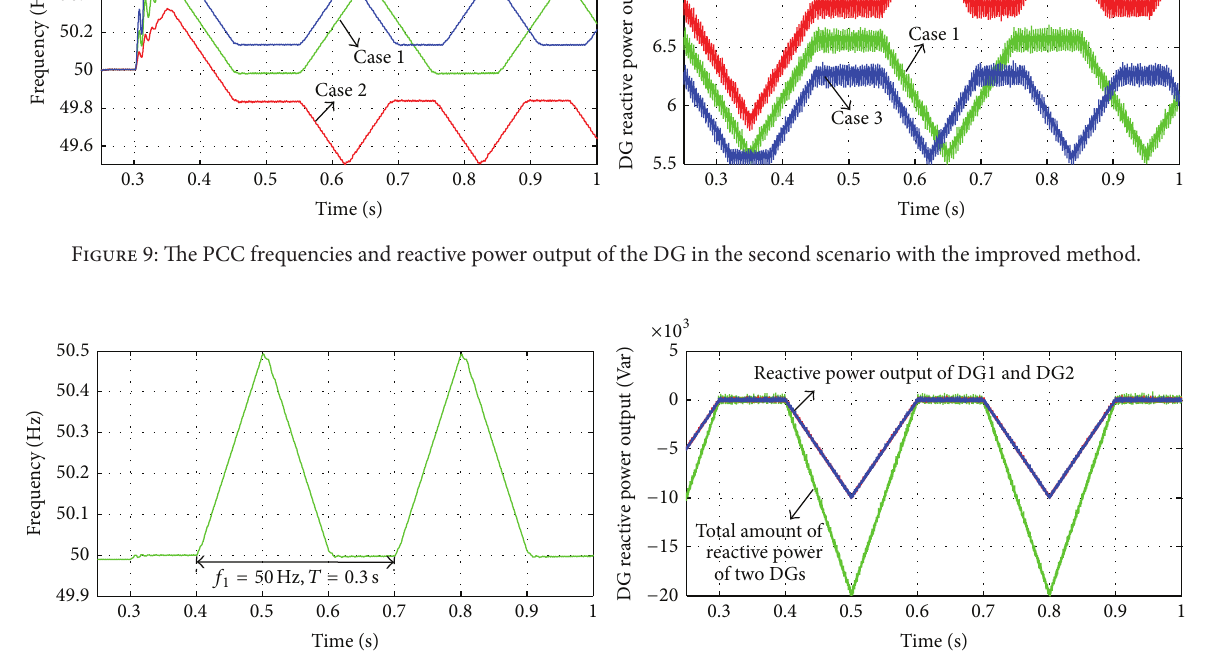
Figure 10: The PCC frequency and the separate and total reactive power output of both DGs in the first